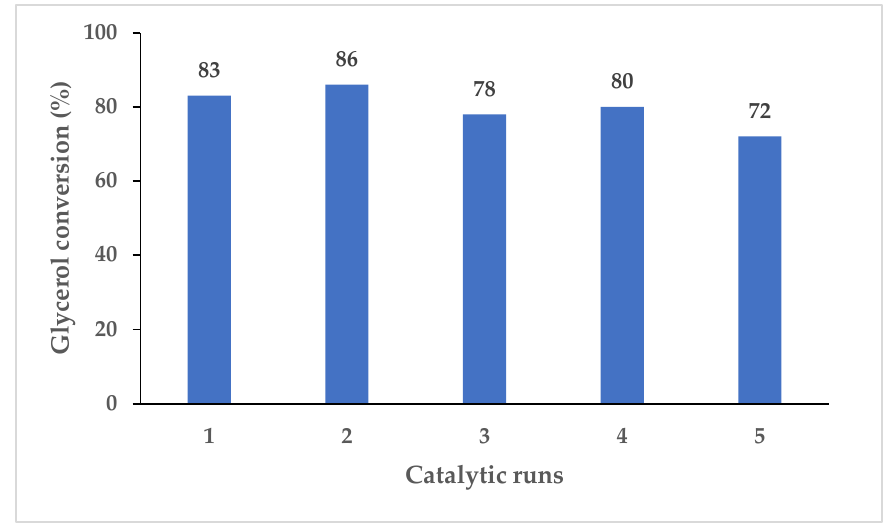
Figure 8. Glycerol acetalization in successive catalytic runs. Reaction conditions: Glycerol:acetone molar ratio 1:4, 3% of catalyst and 120 min of reaction time.